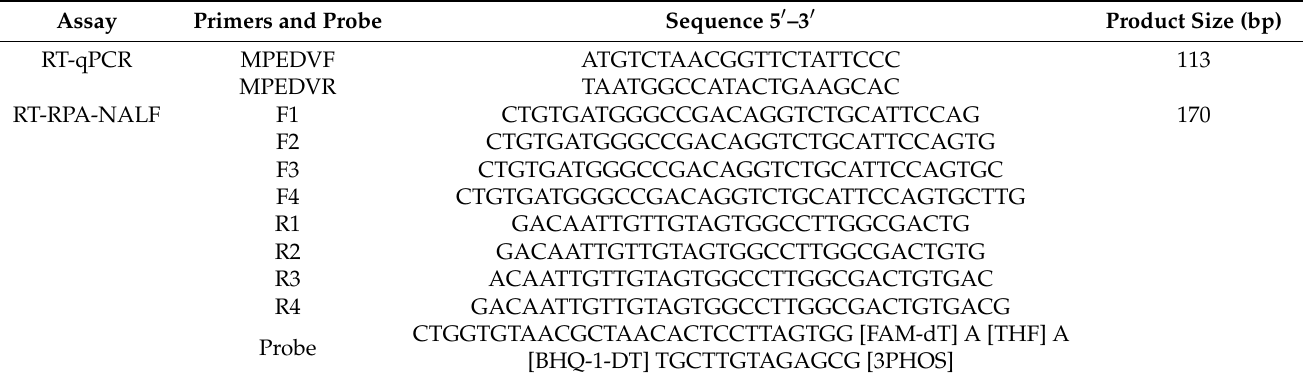
Table 1. Primer and probe sequences for porcine RT-qPCR and RT-RPA-NALF assay used in this study.